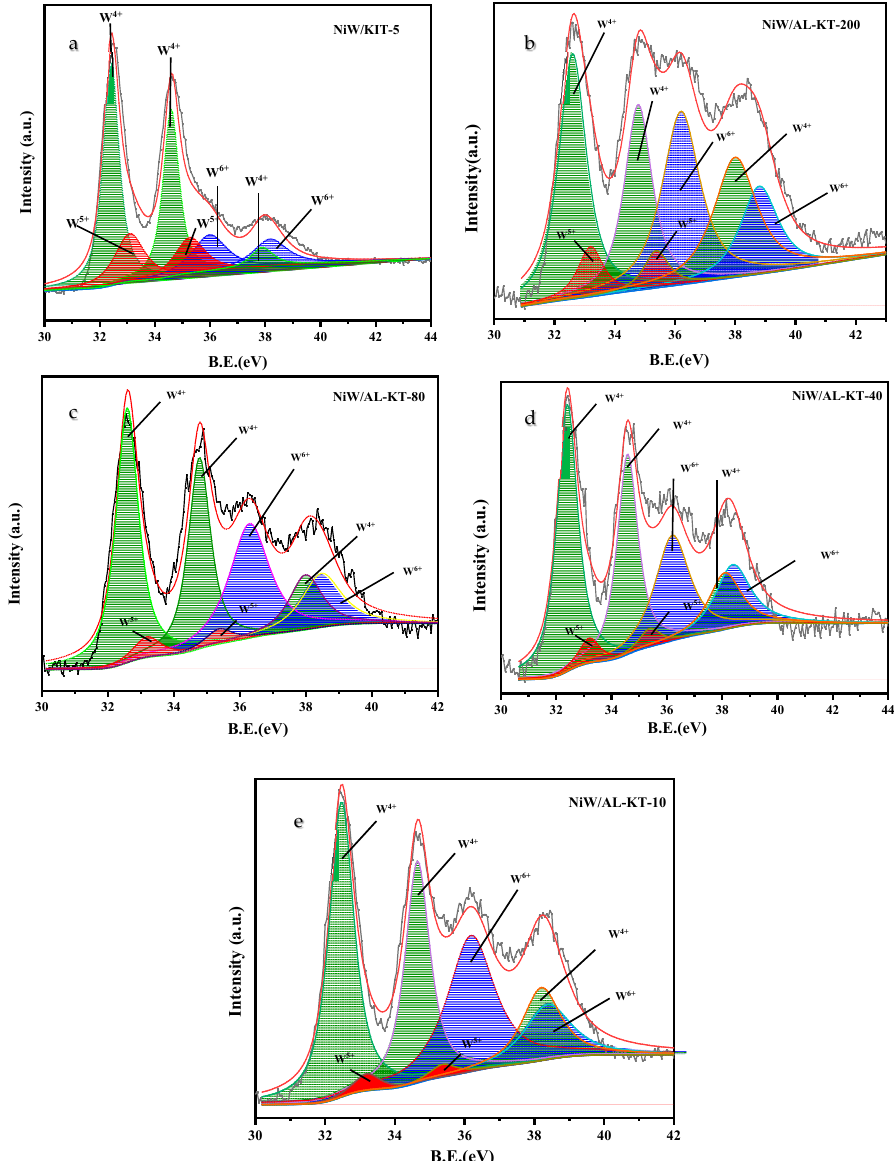
Figure 10. W 4f decomposition spectra of NiWS catalysts. ( a ) NiW/KIT-5; ( b ) NiW/KIT-200; ( c ) NiW/KIT-80; ( d ) NiW/KIT-40; ( e ) NiW/KIT-10